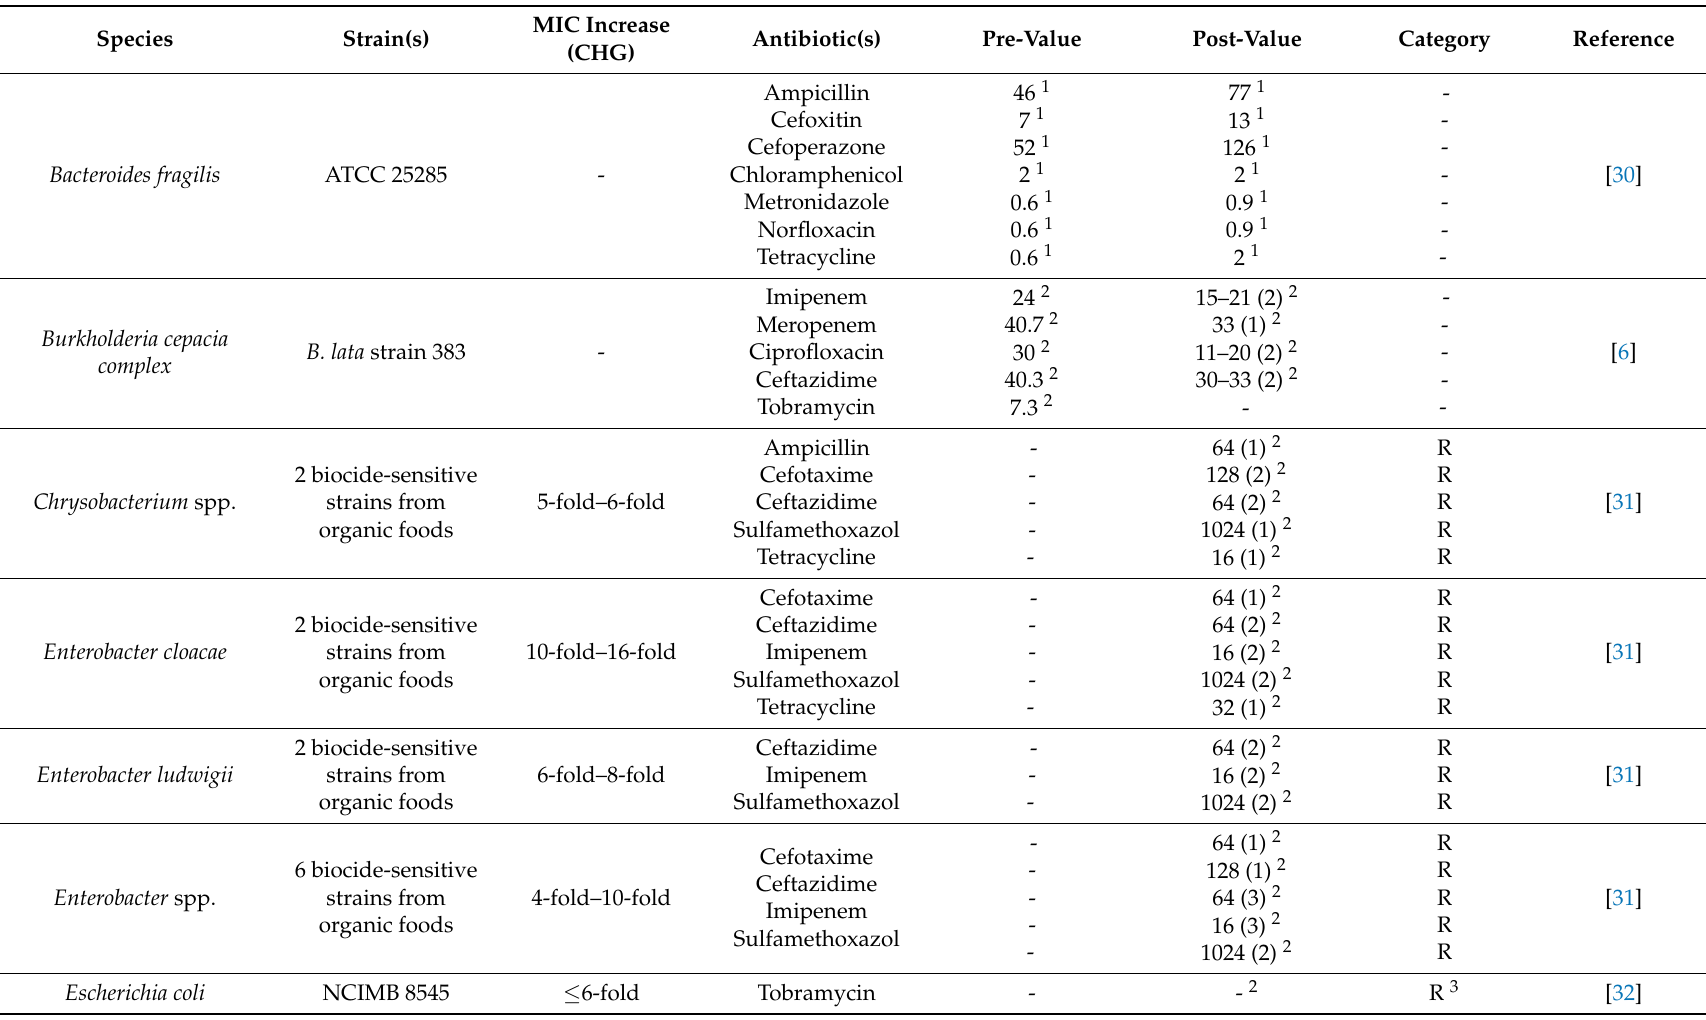
Table 3. Gram-negative species with antibiotic resistance after various types of low level exposure (<MIC value) to chlorhexidine digluconate